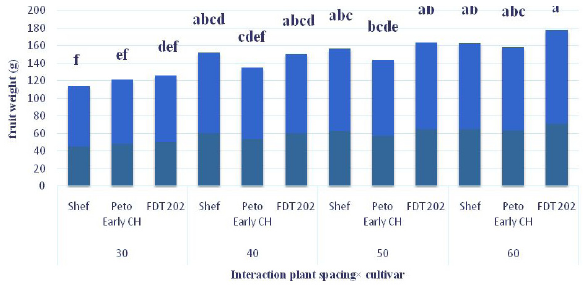
Fig. 3. Interaction between plant spacing × cultivar on fruit